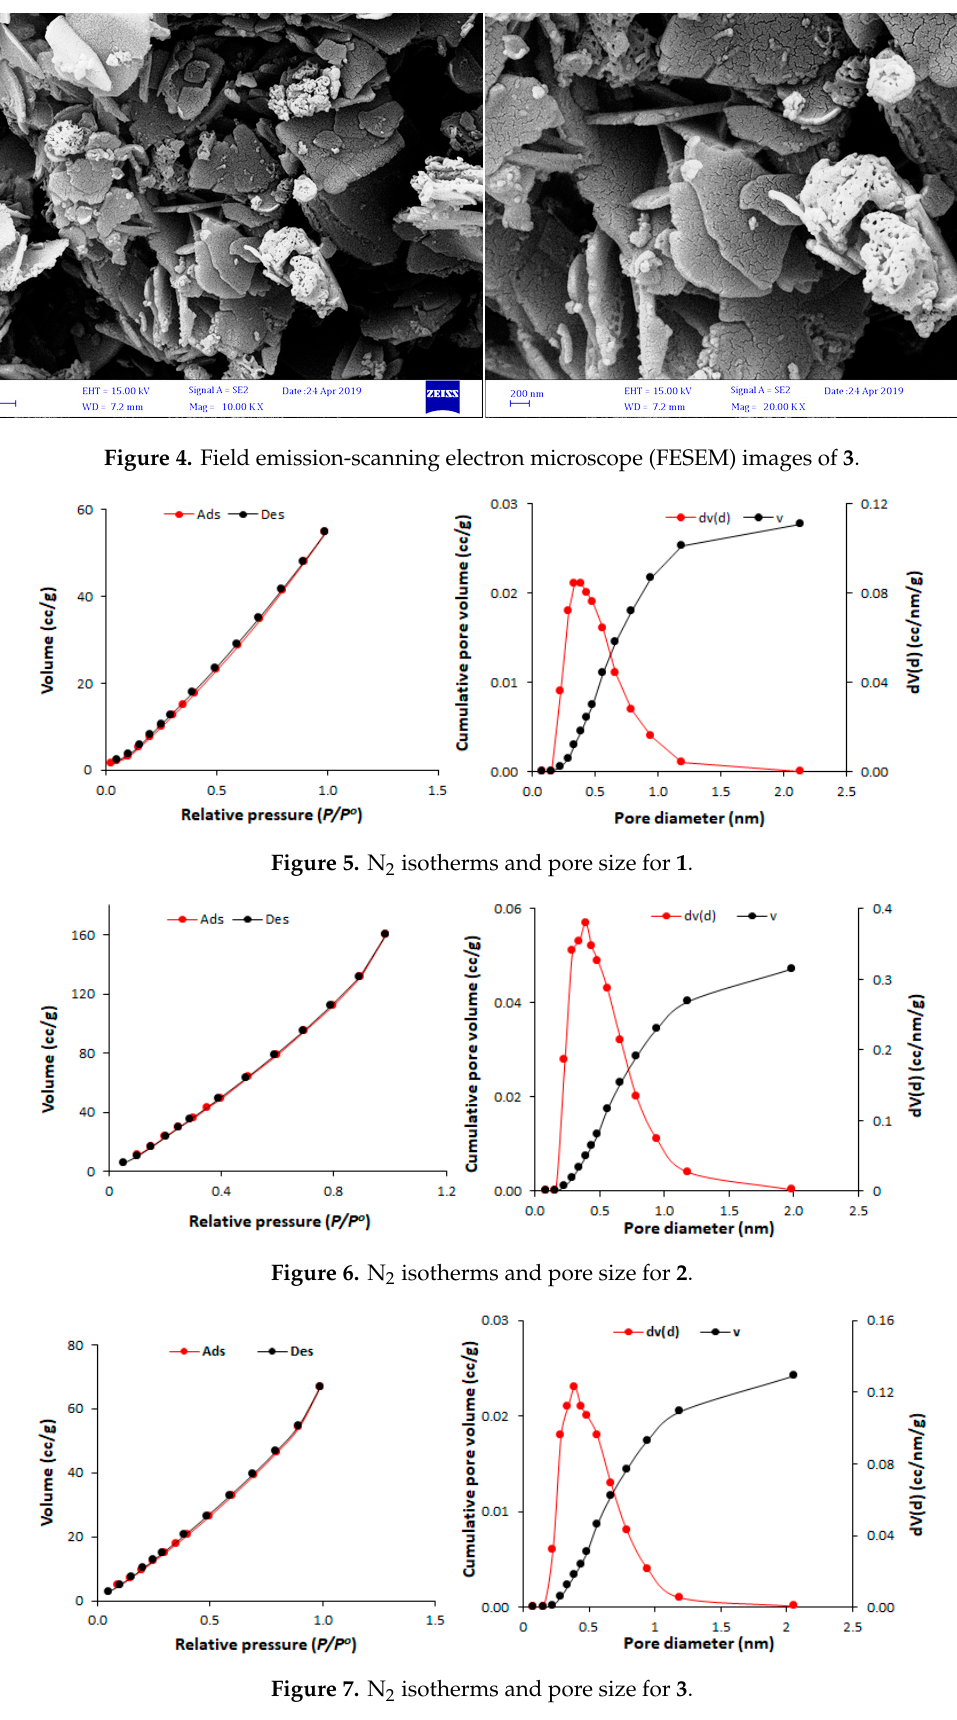
Figure 3. Field emission-scanning electron microscope (FESEM) images of 2 .